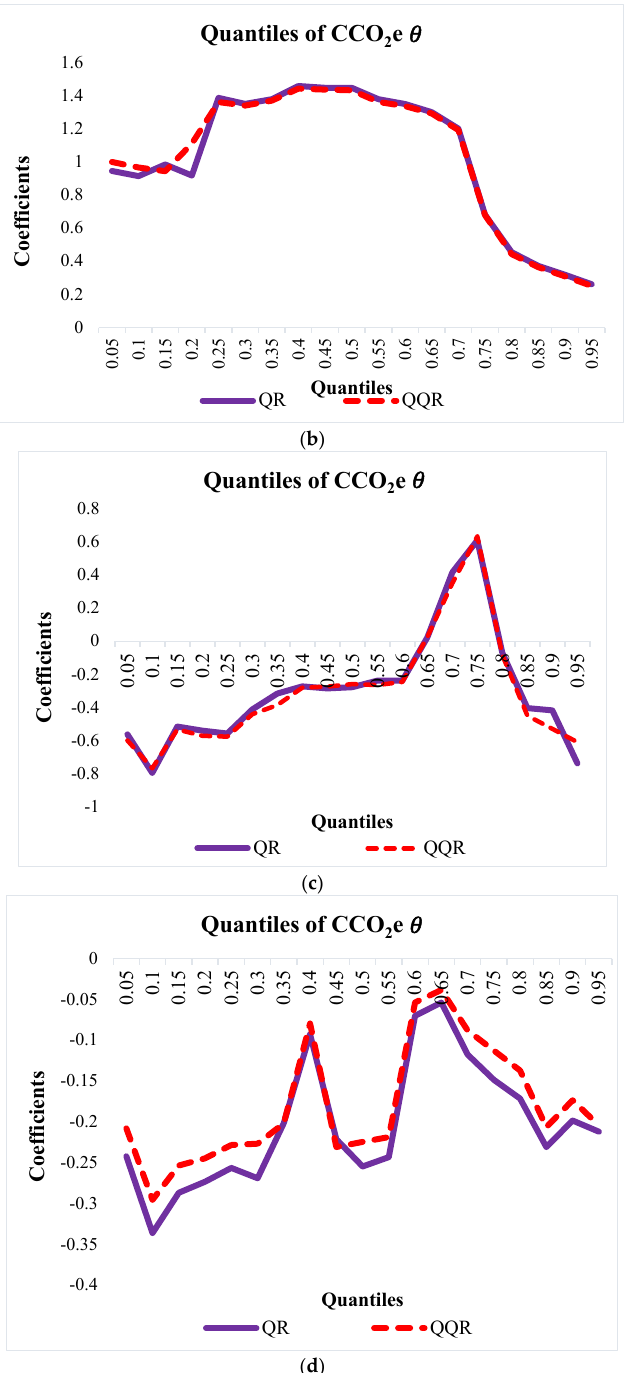
Figure 2. ( a ) Impact of exports on CCO 2 e; ( b ) impact of imports on CCO 2 e; ( c ) impact of renewable energy consumption on CCO 2 e; ( d ) impact of financial development on CCO 2